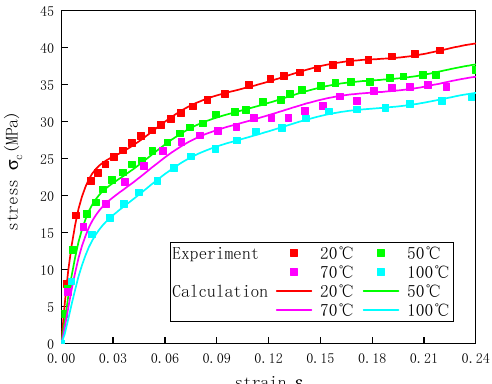
− 1 and di ff erent temperatures.